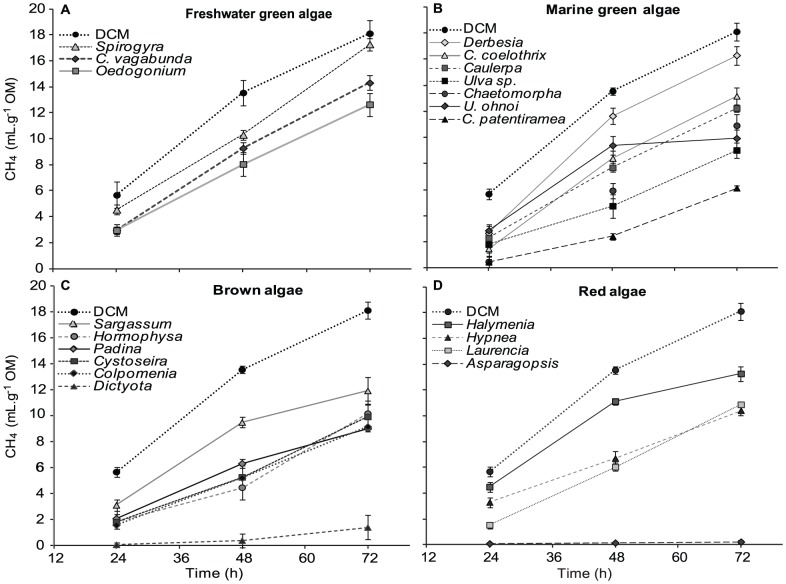
Methane production of macroalgae species at 24, 48, and 72 h.Error bars represent ±SE (n = 3–4). Species full names are given in Table 1.